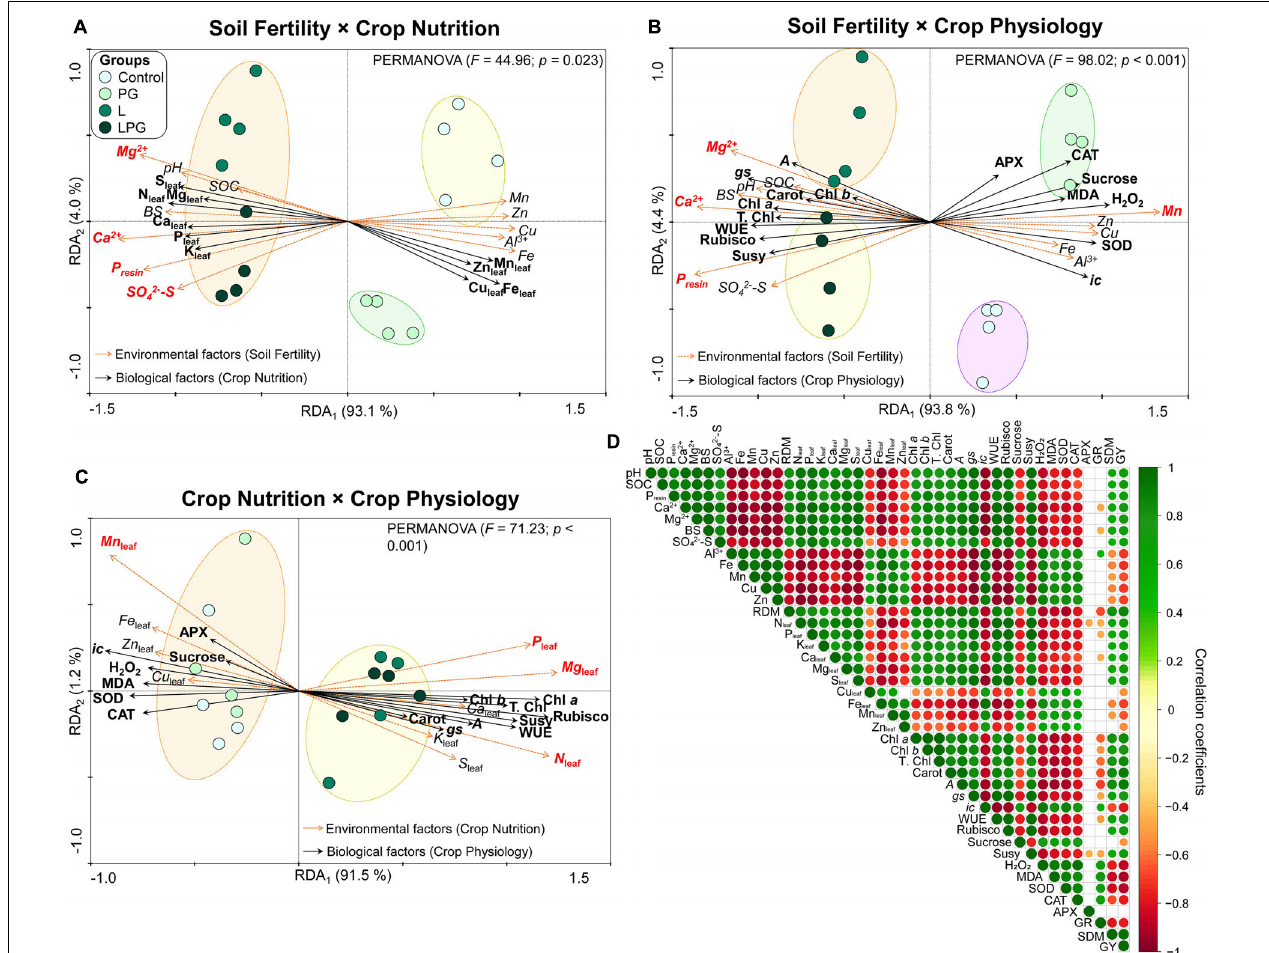
FIGURE 10 | Redundancy analysis triplot (RDA) showing the relationship between the soil fertility × crop nutrition (A) , soil fertility × crop physiology (B) , and crop nutrition × crop physiology (C) . The canonical axes are labeled with percentage of total variance explained (%). The arrows indicate correlations between factors. The significance of these correlations was evaluated by a Monte Carlo permutation test with 999 permutations and the significant soil properties are indicated by red color ( p ≤ 0.05). The color dashed lines indicate significant clusters by permutation analysis (PERMANOVA, p ≤ 0.05). Heatmap showing the correlation coefficients (Pearson) among the soil fertility, root growth, crop nutrition, crop physiology, and agronomic parameters of maize plants (D) . Only significant correlations at p ≤ 0.05 are shown. Soil organic matter (SOC), base saturation (BS), sulfate (SO 42 − -S), root dry matter (RDM), chlorophyll a (Chl a ), Chlorophyll b (Chl b ), total chlorophyll (T. Chl), carotenoids (Carot), Net photosynthesis rate ( A ), stomatal conductance ( gs ), internal CO 2 concentration ( ic ), water use efficiency (WUE), hydrogen peroxide